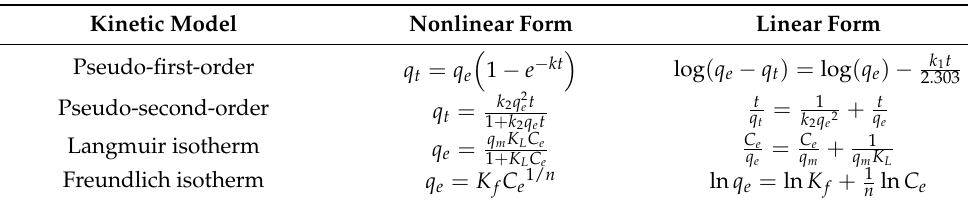
Table 1. Kinetic and isotherm models with nonlinear and linear